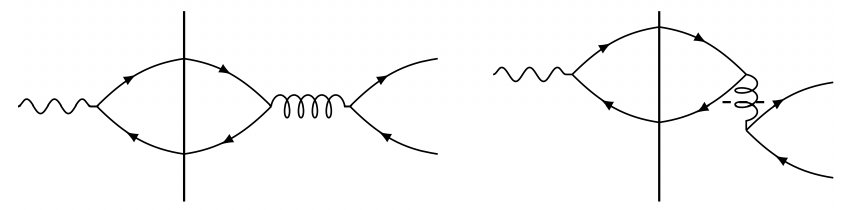
Figure 2 . Two diagrams with a virtual (left) and instantaneous (right) gluon in the s -channel after the shockwave. As explained in the main text, these diagrams disappear when considering only the three lightest